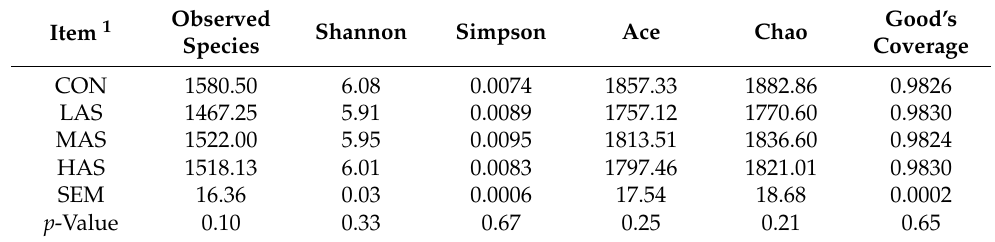
Table 5. Influence of different sulfur content on the alpha diversity of bacterial communities in the